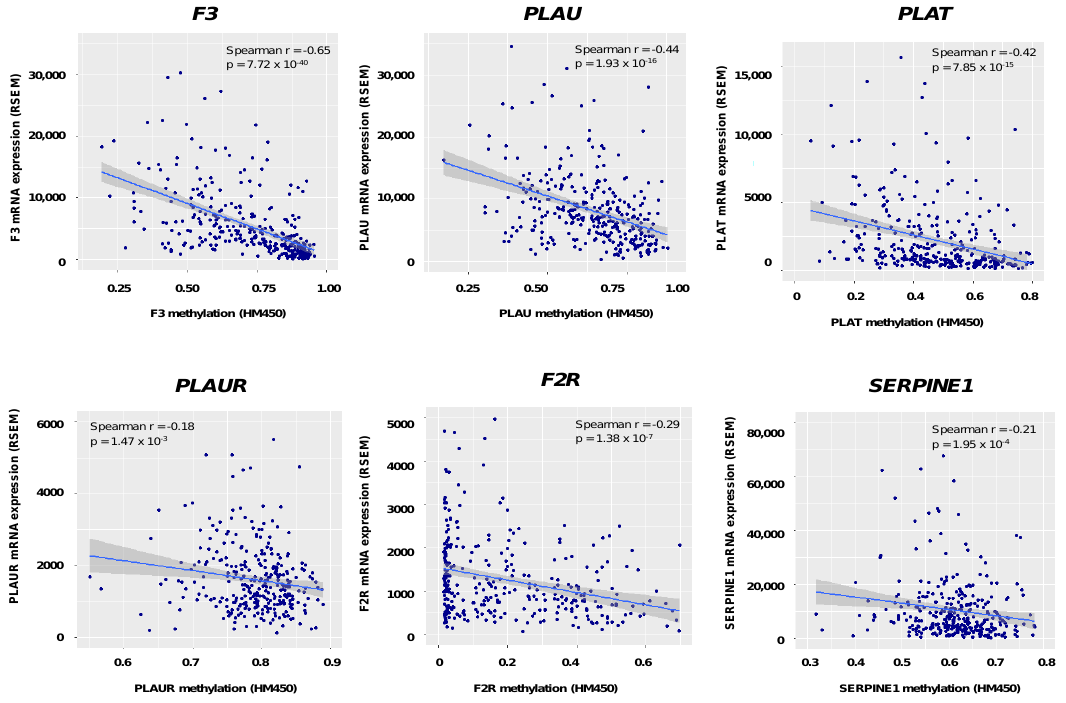
Figure 3. Link between coagulome gene expression and gene methylation. Local DNA methylation was negatively correlated with F3 , PLAU and PLAT gene expression. Graphs showing F3 , PLAU and PLAT mRNA expressions (RSEM) and the CpG methylation levels of the gene promoter (HM450 beta values, 0 = unmethylated, 1 = full methylated). Correlations were performed using Spearman